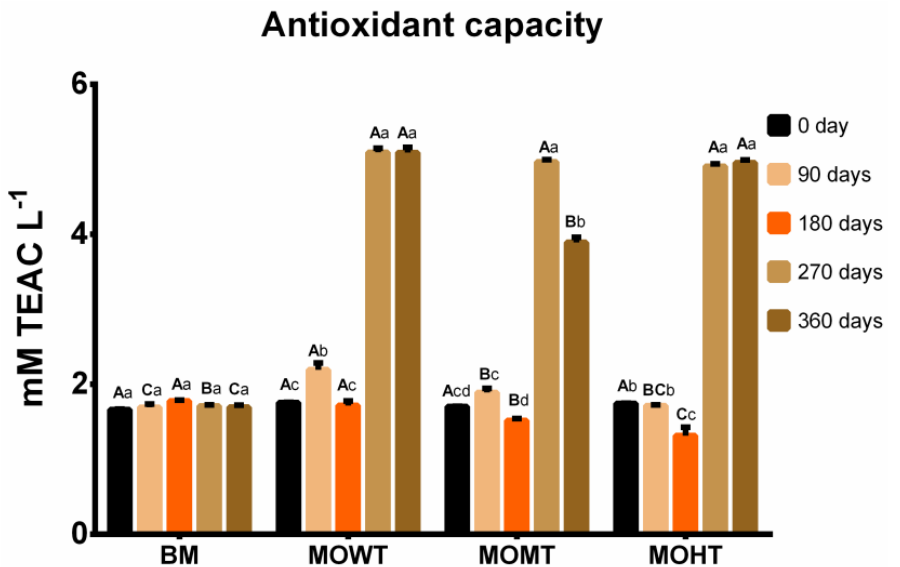
medium toasting; MOHT: mead aged with oak chips at high toasting.